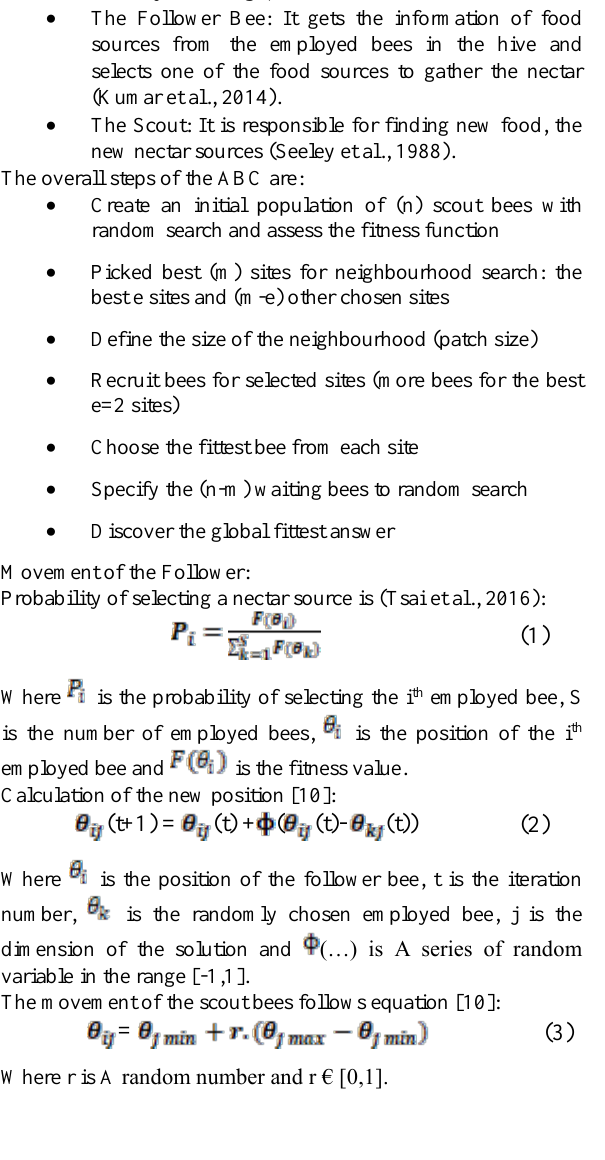
Figure 1. The shape of each answer in algorithm